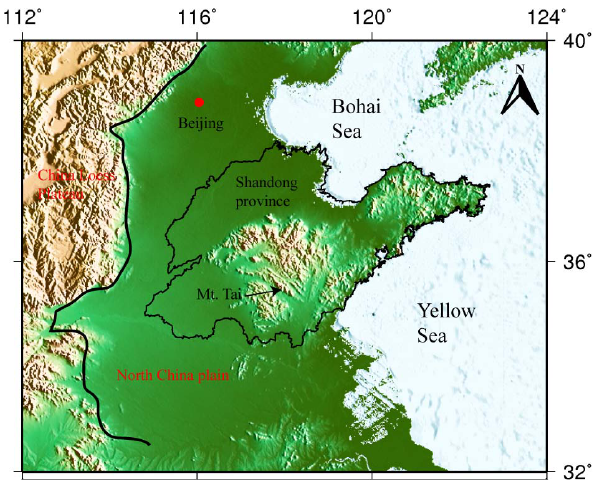
Fig. 1. Map showing Mt. Tai located in Shandong Province in the North China